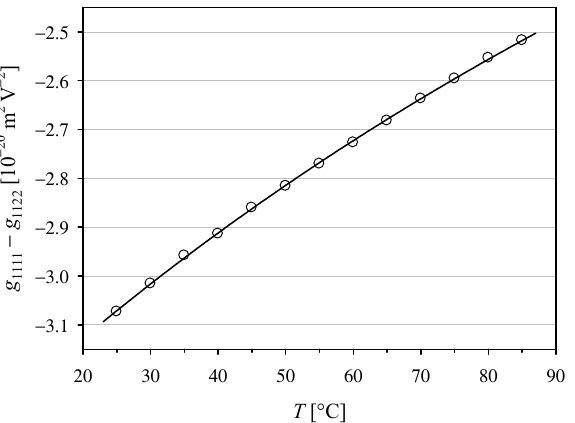
Figure 2. Temperature dependence of the quadratic electro-optic coefficient g 1111 − g 1122 with second- order polynomial interpolation g 1111 − g 1122 [10 − 20 m 2 V − 2 ] = − 3.356 + 0.01215 T − 0.000027 T 2 for T given in [°C].